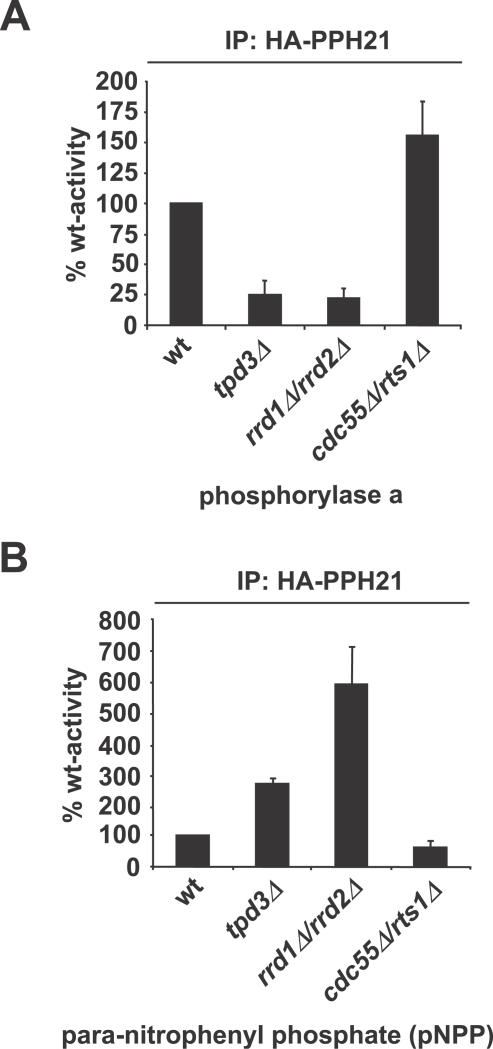
Loss of TPD3 Leads to a Decreased Serine/Threonine Phosphatase Activity and Altered Substrate Specificity of the PP2A C SubunitThe catalytic activity of anti-HA immunoprecipitates from lysates of wild-type (wt), tpd3Δ, rrd1Δ/rrd2Δ, and cdc55Δ/rts1Δ cells expressing HA-tagged PPH21 was analyzed by phosphatase assays towards (A) phosphorylase a (n = 12, mean ± standard deviation) or (B) para-nitrophenyl phosphate, pNPP (n = 4, mean ± standard deviation). An additional background measurement (corresponding to the wild-type strain containing the empty vector pYX142 was included for every assay (A and B) and subtracted from each measuring point (see Materials and Methods for more details).